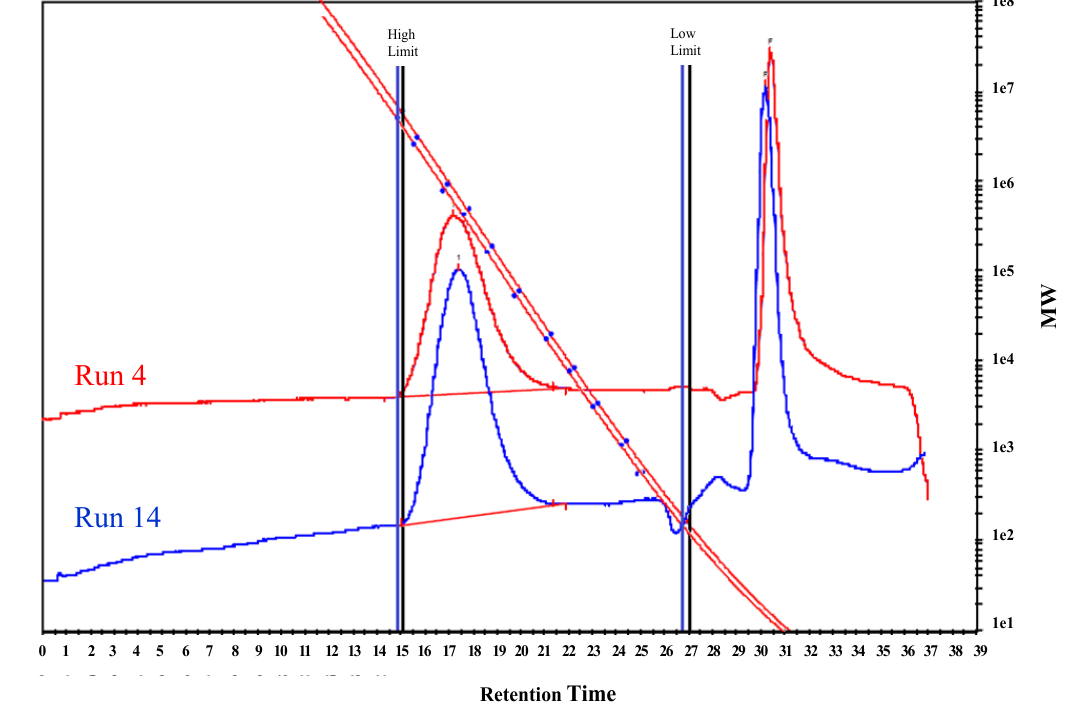
Figure 2. GPC diagram of polyethylene provided by runs 4 and 14.